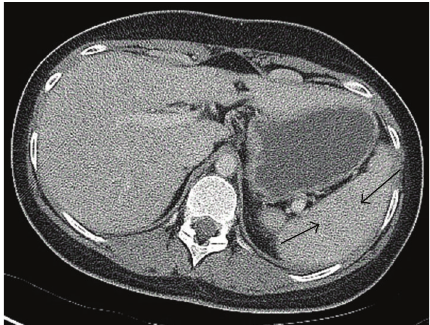
Figure 2: Resolution of the patient’s splenic abscesses 6 months following treatment initiation (previously effected regions denoted by